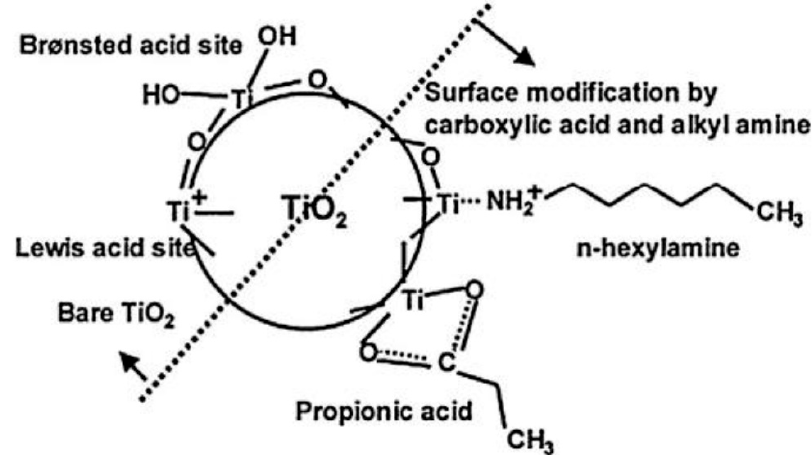
Figure 1. Surface functionalization of TiO 2 nanoparticle by carboxylic acid and alkyl amine [17].